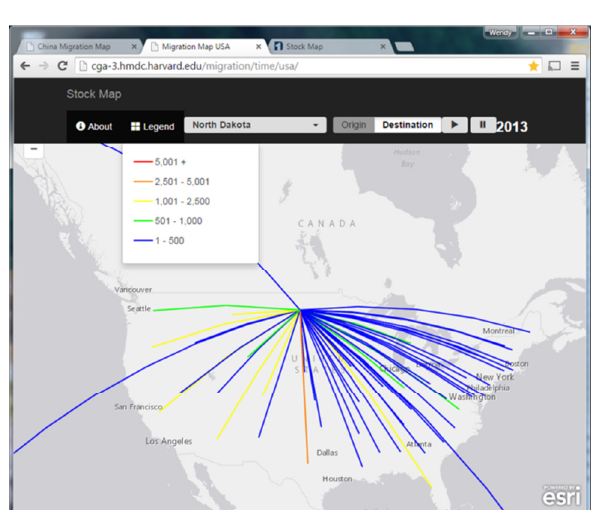
Figure 5a Migration into North Dakota in 2009